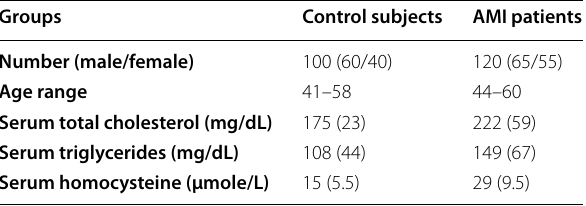
Categorical data are presented as number. Continuous data are presented as median (IQR)